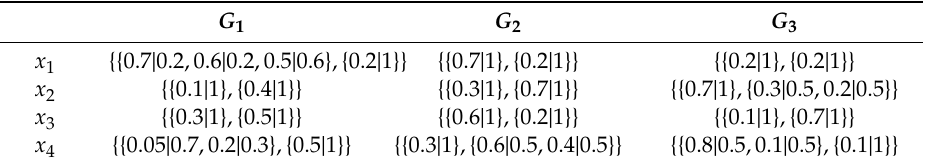
Table 9. The decision matrix of Example 6.